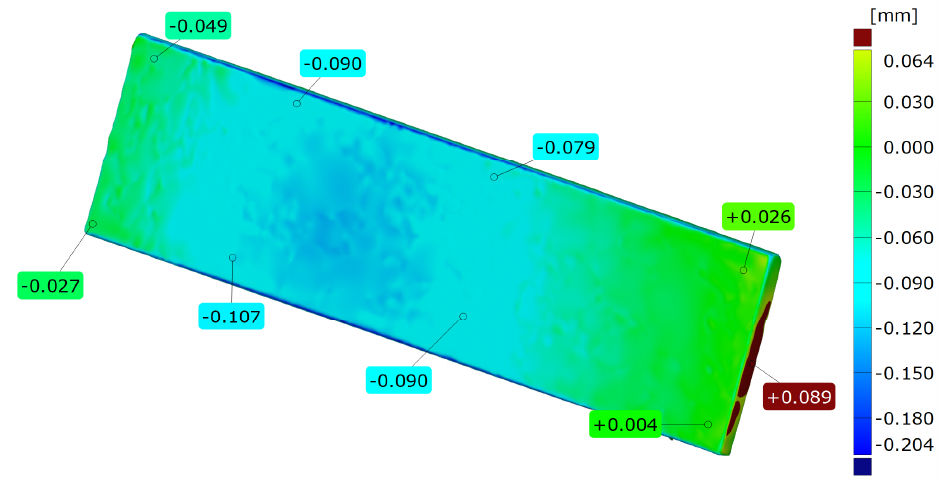
Figure 5. The results of 3D optical scanning tests of samples made of AlSi10Mg-cast.